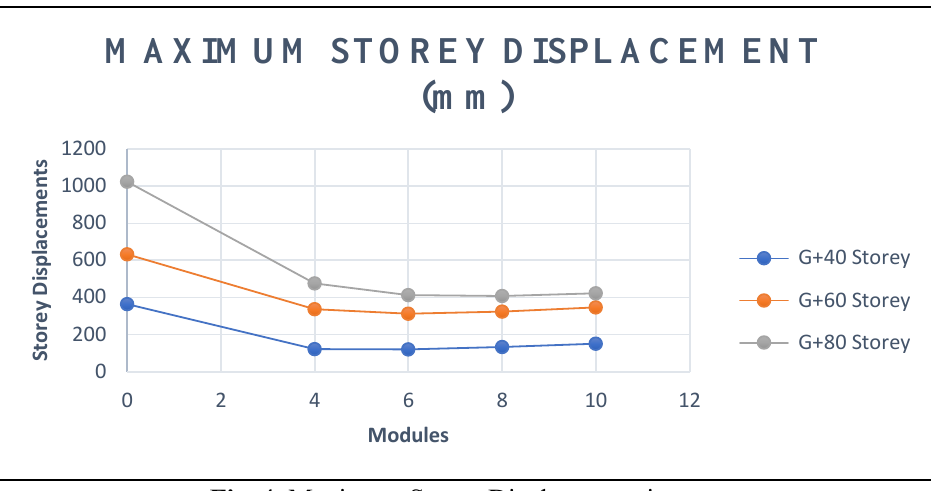
Fig. 4 . Maximum Storey Displacement in